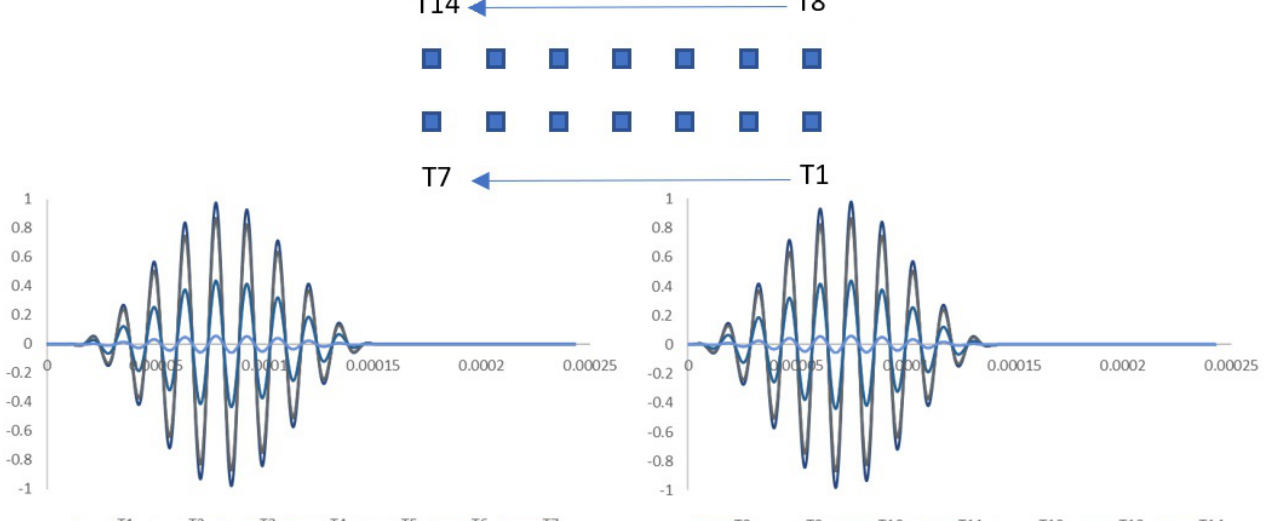
Figure 11. Apodisation of the amplitude of the excitation signal applied across each row of 7 × 2 array transduction points.